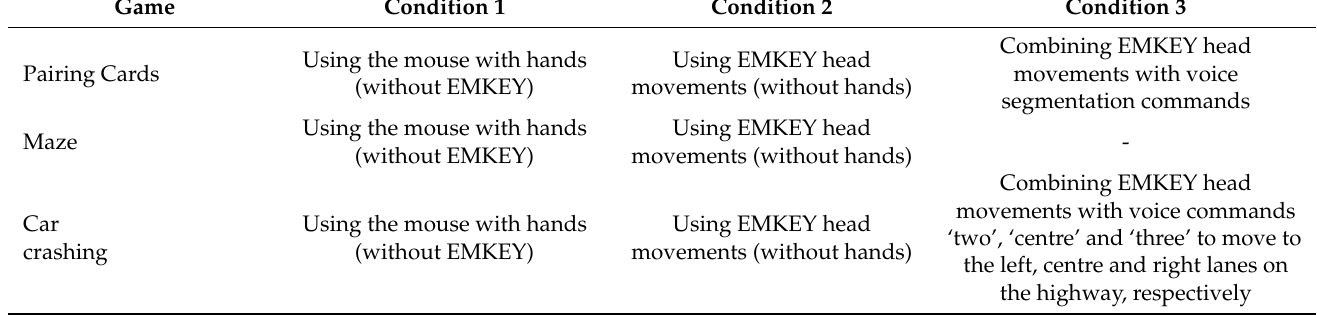
Table 2. Experimental conditions for each game.